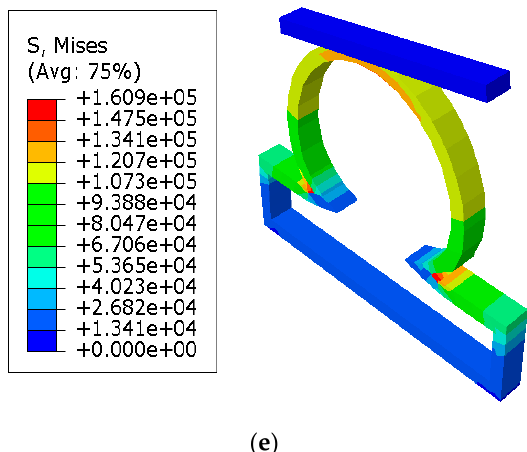
Figure 3. Finite element simulations of stresses (Pa) on axisymmetric intracranial saccular aneurysm for the cases where ( a ) lesions without constraints, ( b ) lesions with short contact constraints (20 mm), ( c ) lesions with long contact constraints (40 mm), ( d ) lesions with point load on the fundus, and ( e ) lesions with long contact constraints at an angle of 10 degrees from the horizontal axis. The associated stress results for all lesions were performed under the applied uniform pressure of P = 120 mmHg.